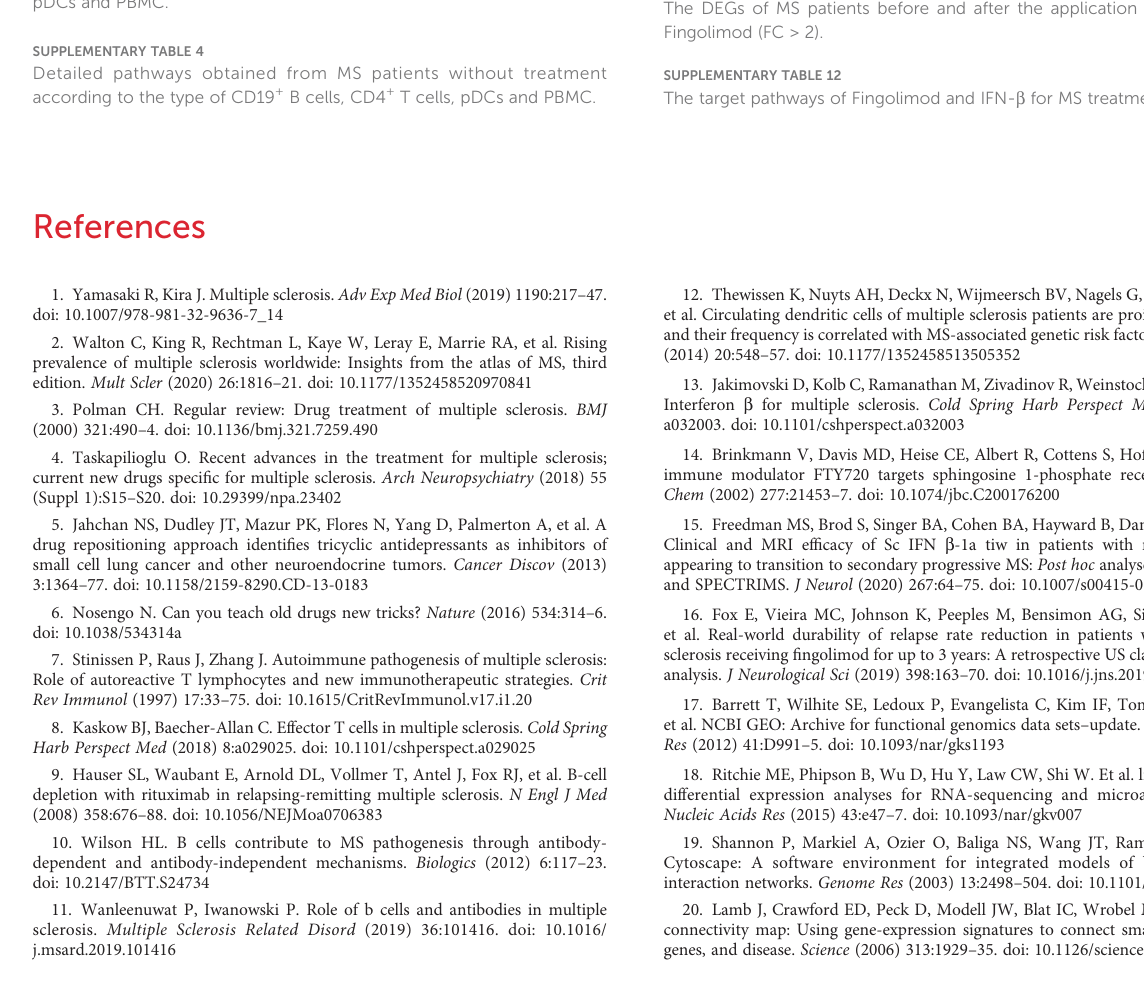
SUPPLEMENTARY TABLE 5 Detailed pathways obtained from MS patients before and after the application of Fingolimod and IFN- b according to the type of CD19 + B cells, CD4 + T cells, pDCs and PBMC. SUPPLEMENTARY TABLE 6 Detailed candidate drugs for targeting target pathways obtained from the KEGG database according to the types of CD19 + B cells, CD4 + T cells, pDCs and PBMC. SUPPLEMENTARY TABLE 7 Detailed candidate drugs for targeting 2 target pathways obtained from the KEGG database according to the types of CD19 + B cells, CD4 + T cells, pDCs and PBMC. SUPPLEMENTARY TABLE 8 The genes differentially expressed in CD4 + T cells of MS patients without treatment at both mRNA and protein levels. SUPPLEMENTARY TABLE 9 \The pathways that were enriched by genes differentially expressed in CD4 + T cells of MS patients without treatment at both mRNA and protein levels. SUPPLEMENTARY TABLE 10 The DEGs of MS patients and healthy individuals (FC > 2). SUPPLEMENTARY TABLE 11 The DEGs of MS patients before and after the application of IFN- b or Fingolimod (FC >